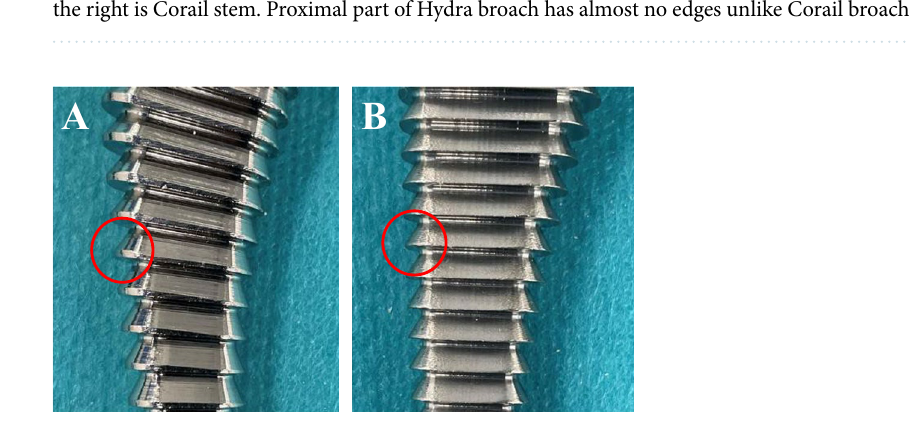
Figure 2. Different shapes of the edge at each broach. The edge is relatively dull in the Corail broach ( A ), whereas it is sharp in the Hydra broach ( B